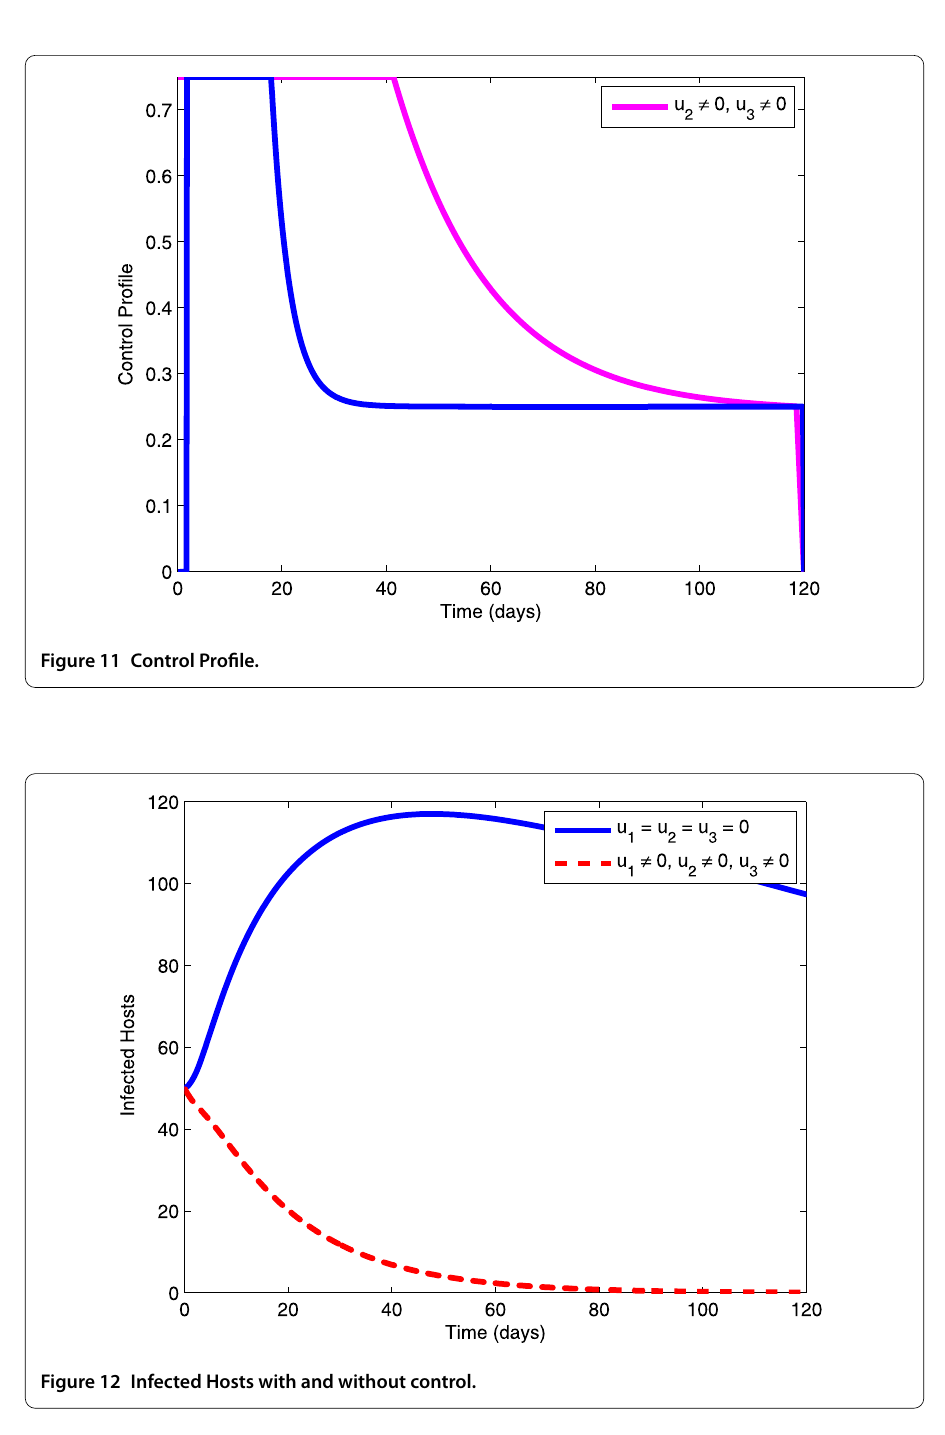
Figure 12 Infected Hosts with and without